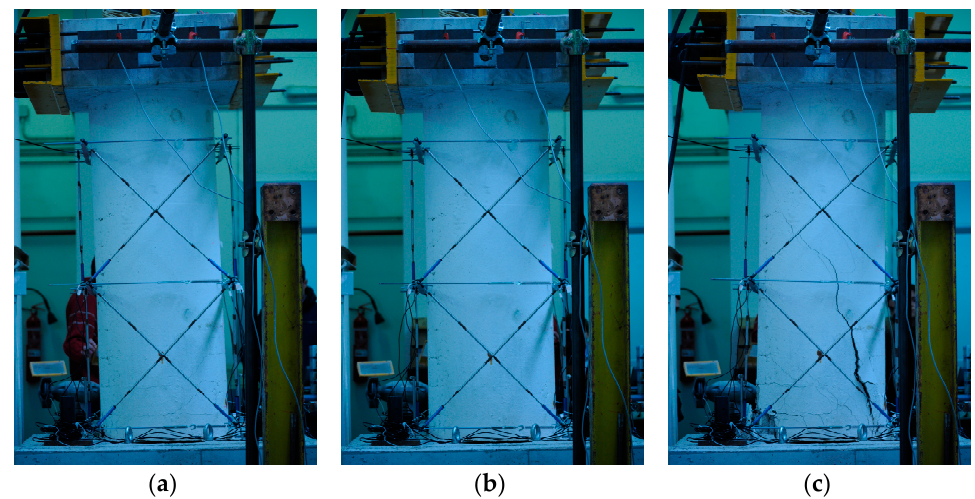
Figure 20. Pier images during the cyclic test at time: ( a ) test beginning, ( b ) first shear cracking at fourth drift and ( c ) final crack pattern—circular pier.